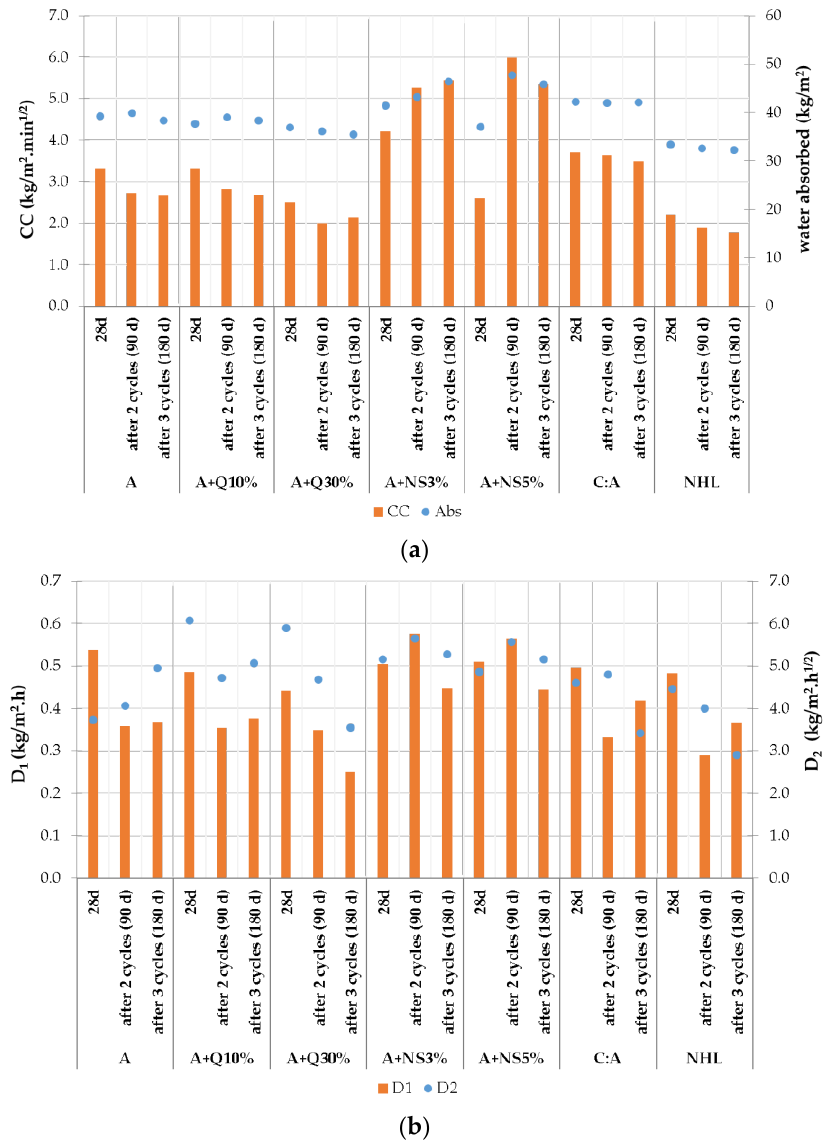
Figure 11. Hydric properties of the mortars with siliceous sand, after cycles of the water absorption: ( a ) water absorption; ( b ) water